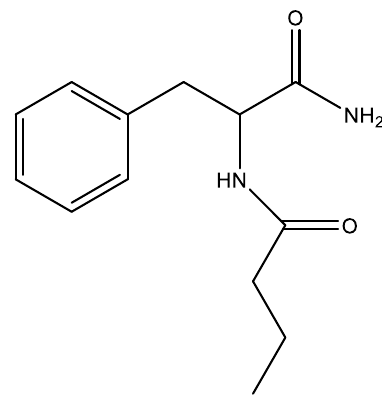
Figure 1. Phenylalanine butyramide